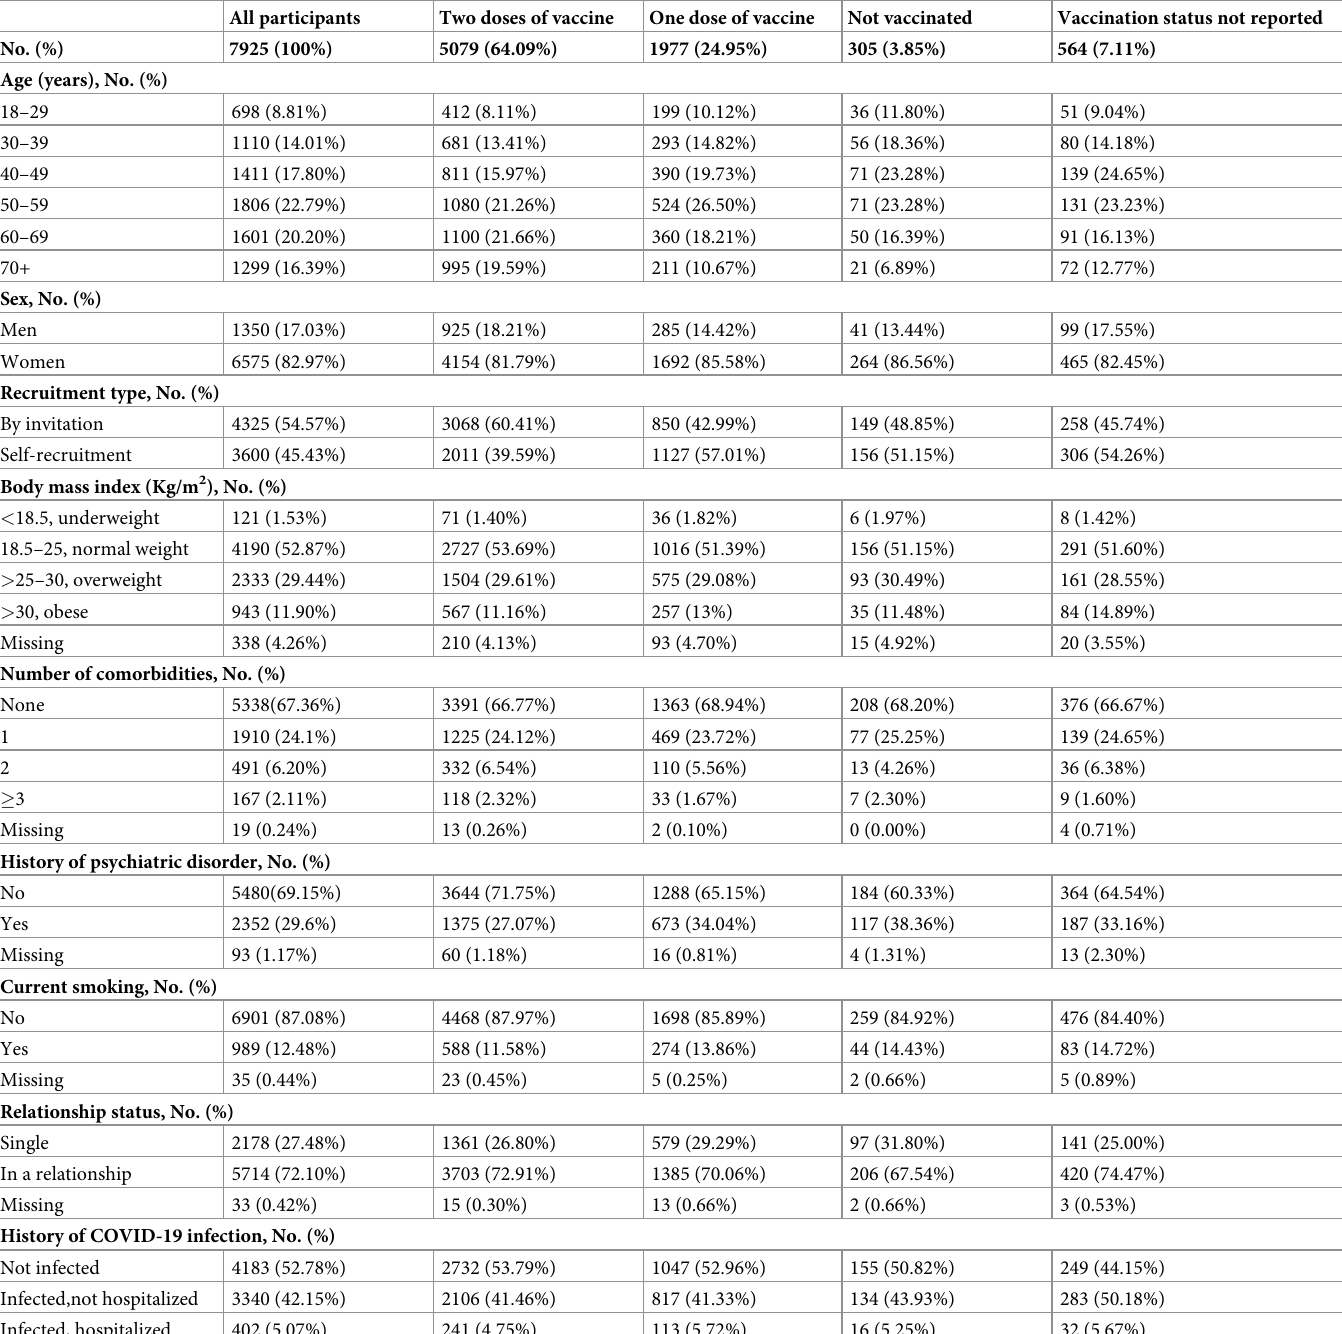
Table 1. Baseline characteristics of the study participants by vaccination